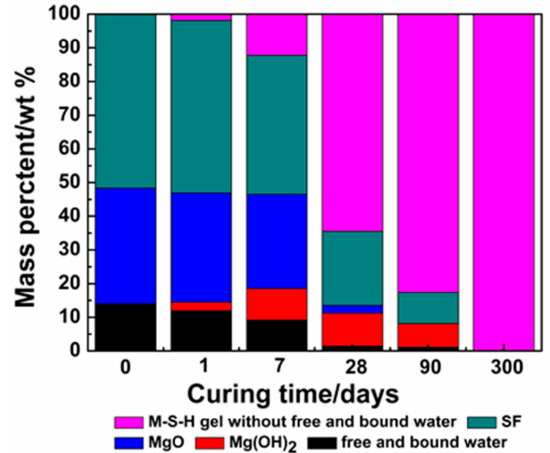
Figure 10. Quantitative analysis of the phase content of MSH samples cured for 300 days via multi-technique approach.